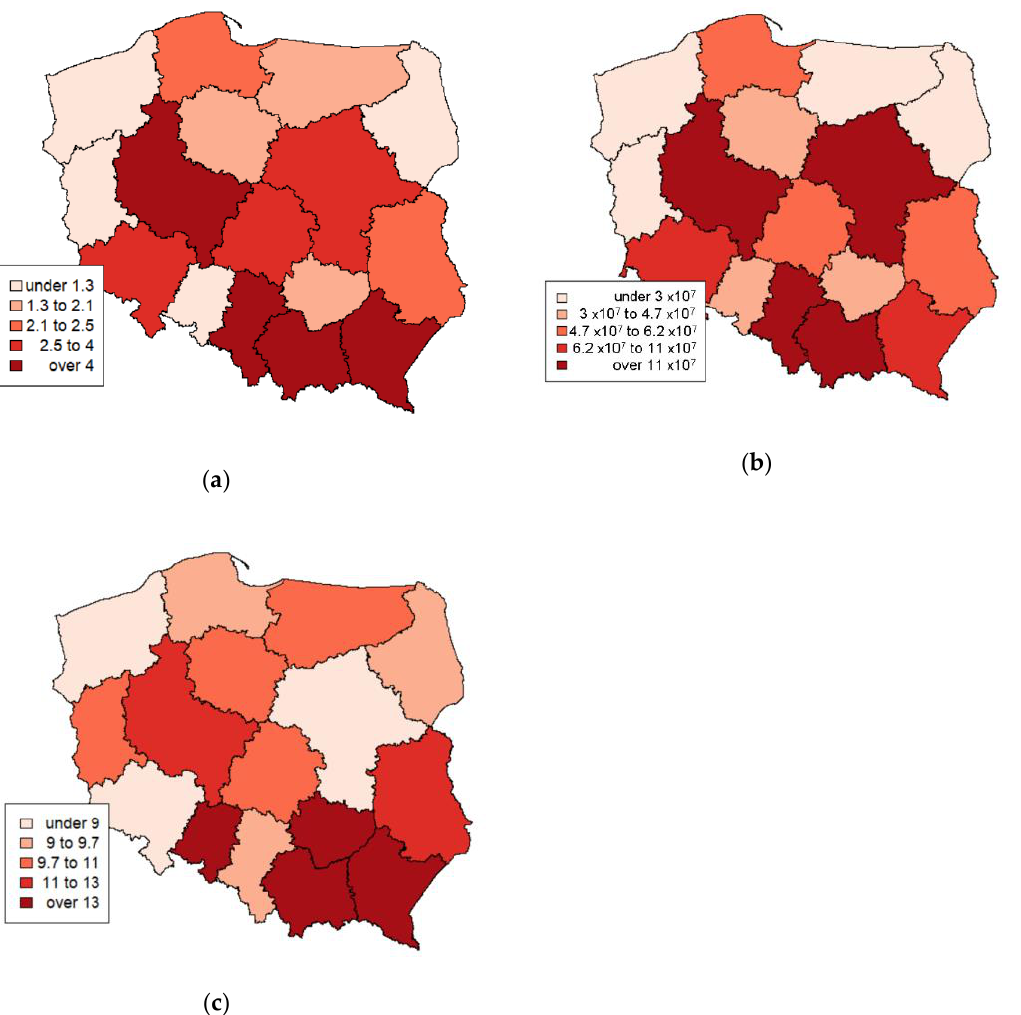
Figure 7. Spatial distribution of economic variables. ( a ) Salary in thousand PLN. ( b ) Total subsidies to micro PV systems in PLN. ( c ) Number of PV installations per 100 million GDP in the re- gion.